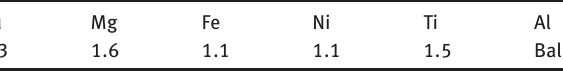
Table 1: Nominal chemical compositions of alloy 2618-Ti (wt.%) Cu Mg Fe Ni